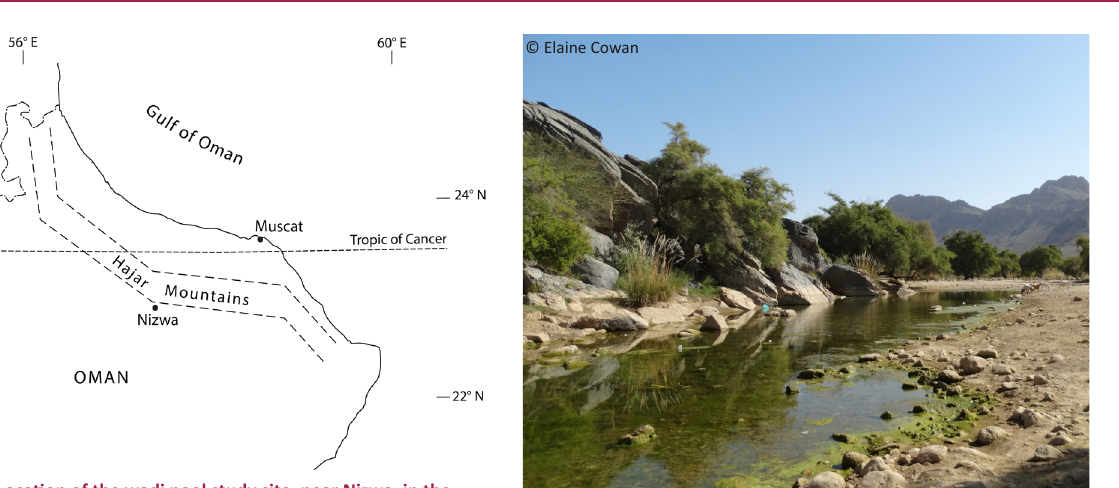
Figure 1. Location of the wadi pool study site, near Nizwa, in the southern foothills of the Jebel Akhdar range, the highest section of the Hajar mountains of northern